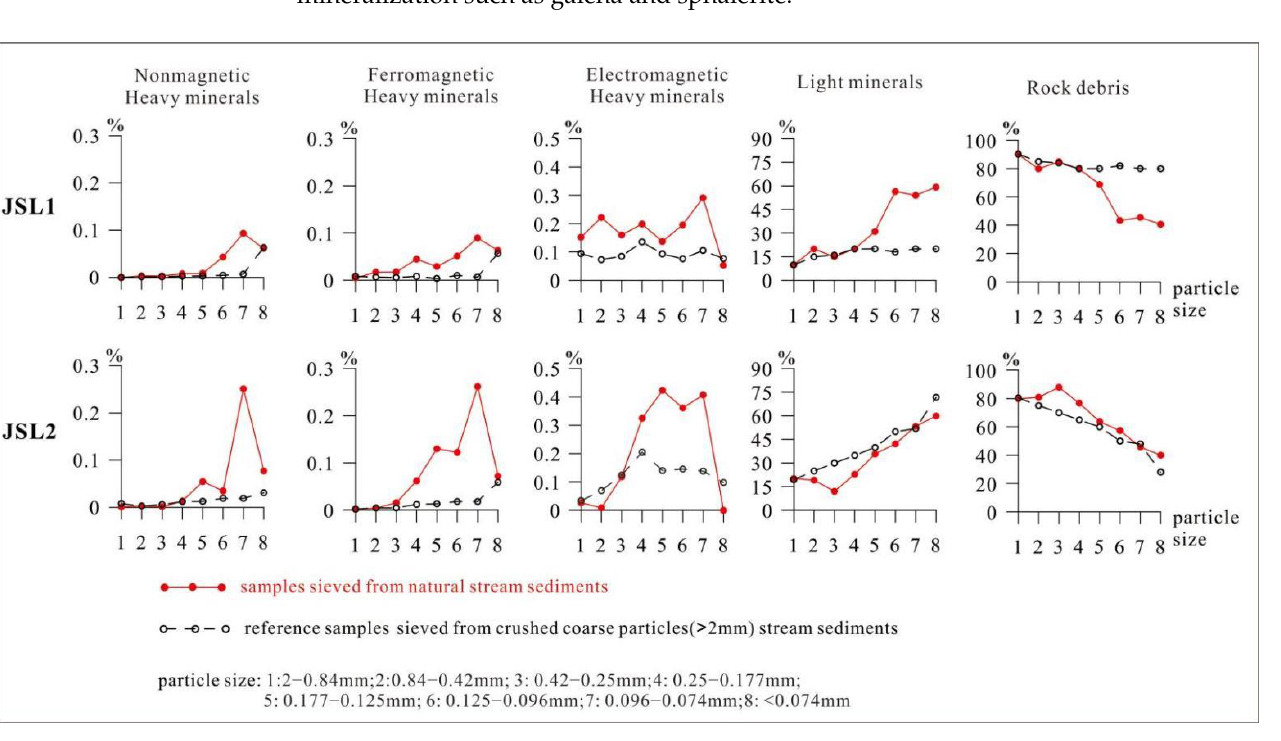
Figure 5. Mineral distribution in different particle size fractions of the stream sediments.